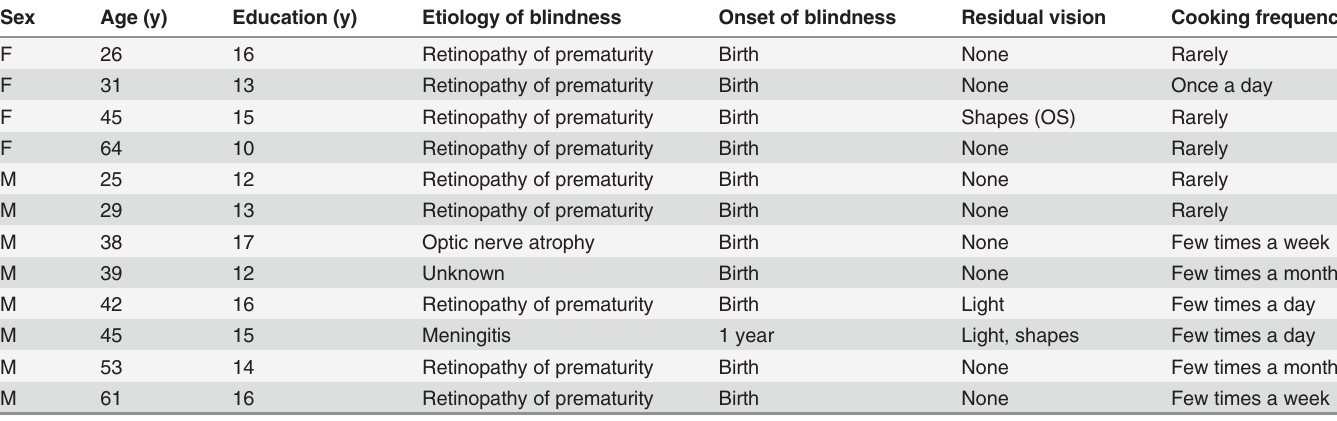
Table 1. Demographic data of blind